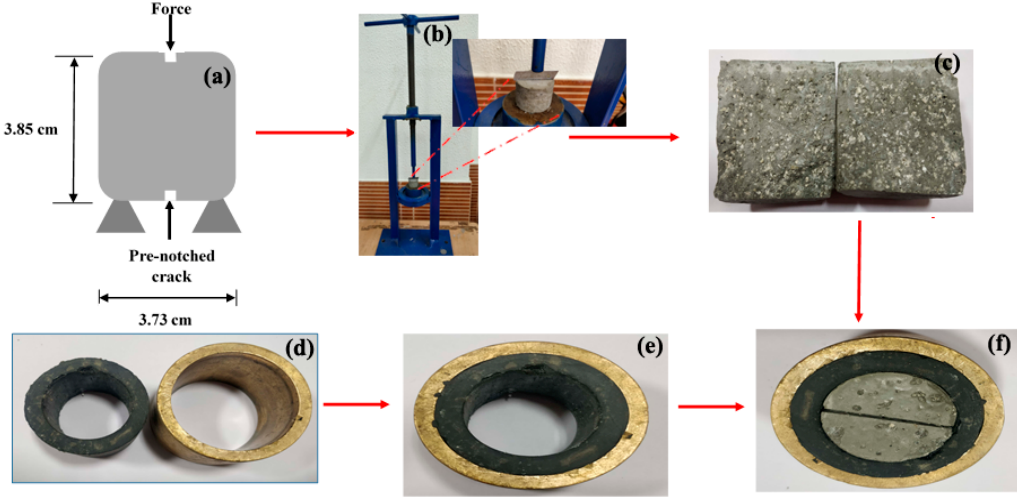
Figure 3. Schematic diagram of the cement core with a single penetrating crack for the flow measurement ( a ) pre-notched specimen subjected to crack generation ( b ) crack generation ( c ) snapshot of split specimen ( d – e ) core holder ( f ) assembled core with artificial crack.